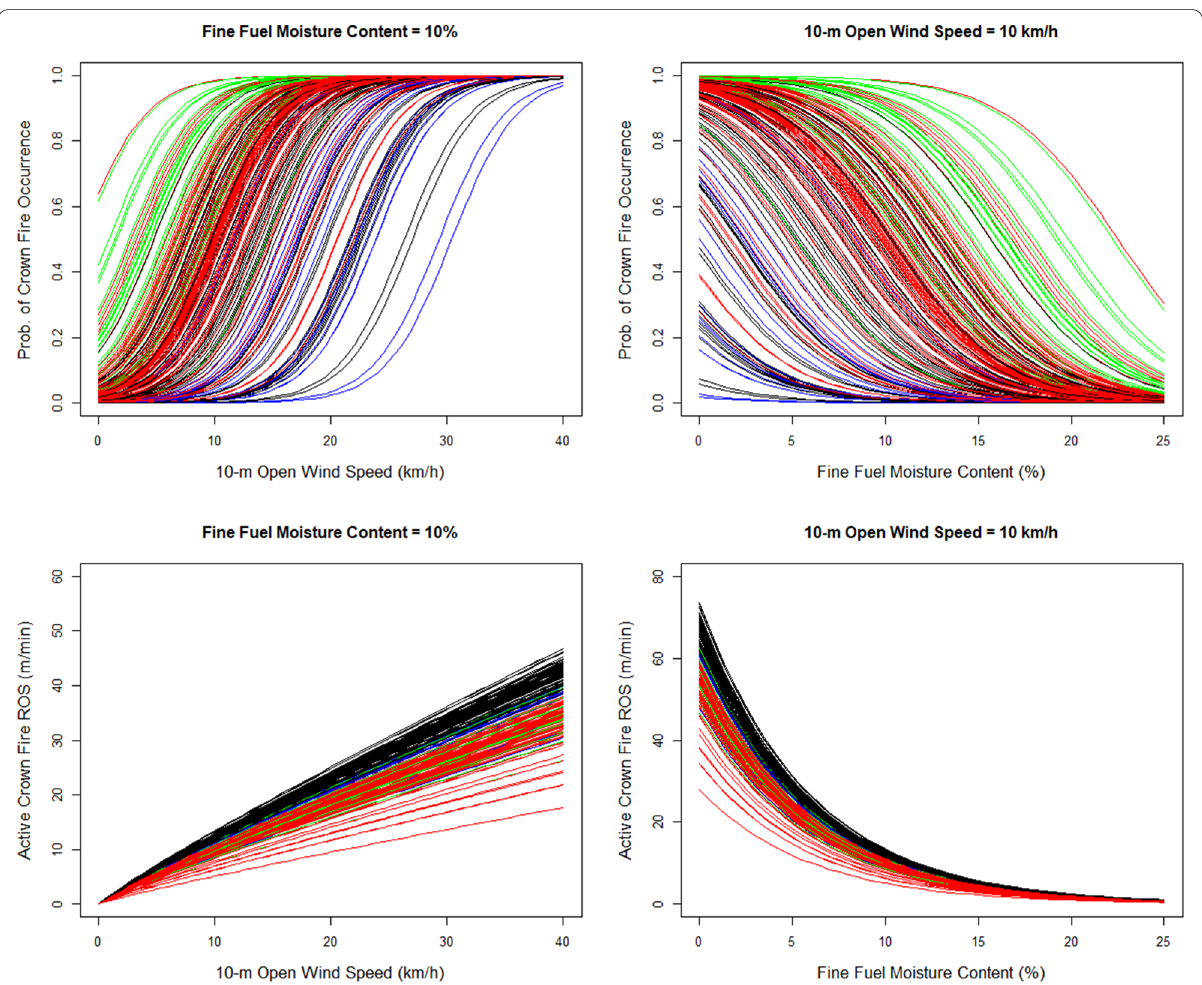
Fig. 6 Plots of the probability of crown fire occurrence and active crown fire rate of spread (ROS) for every C-2 Boreal Spruce stand included in the study, based on various 10-m open wind speeds and fine fuel moisture contents. The fuel class cluster (FCC) of the stand is represented by the colour of the